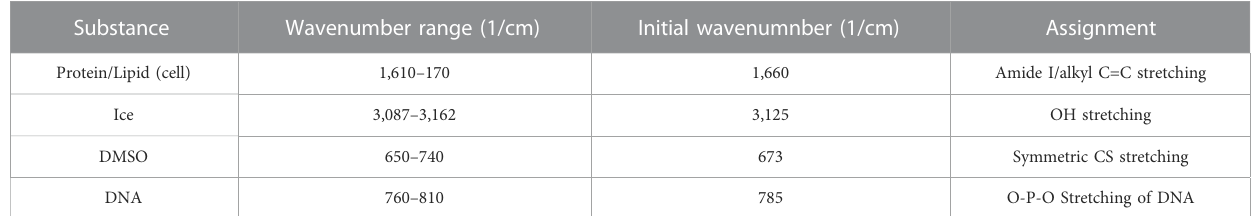
TABLE 1 Characteristic Raman spectral peaks of